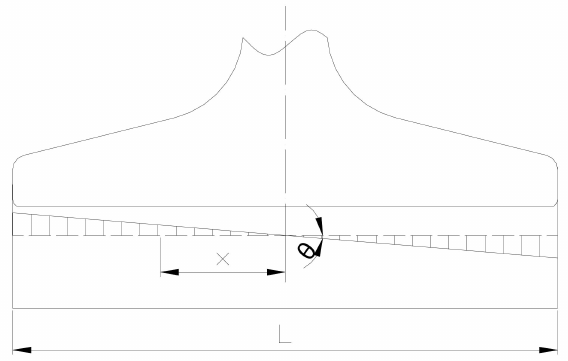
Figure 9. Schematic of rail tipping.